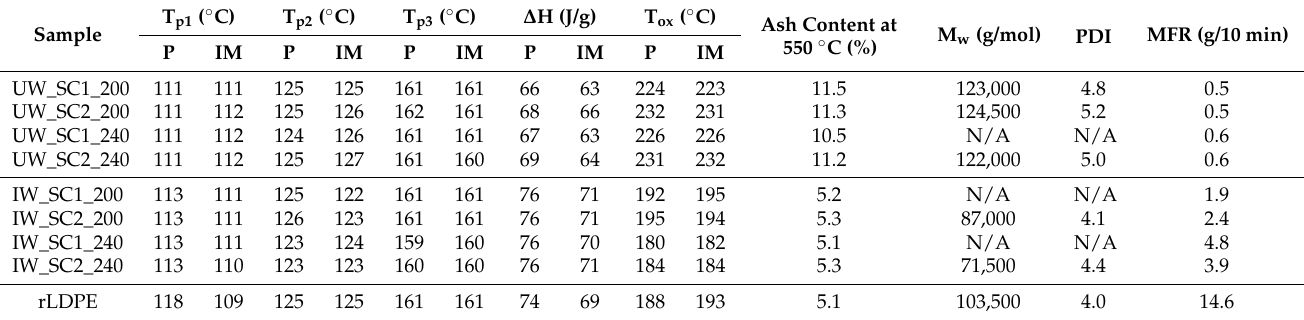
Table 2. The thermal, structural, and rheological properties of the